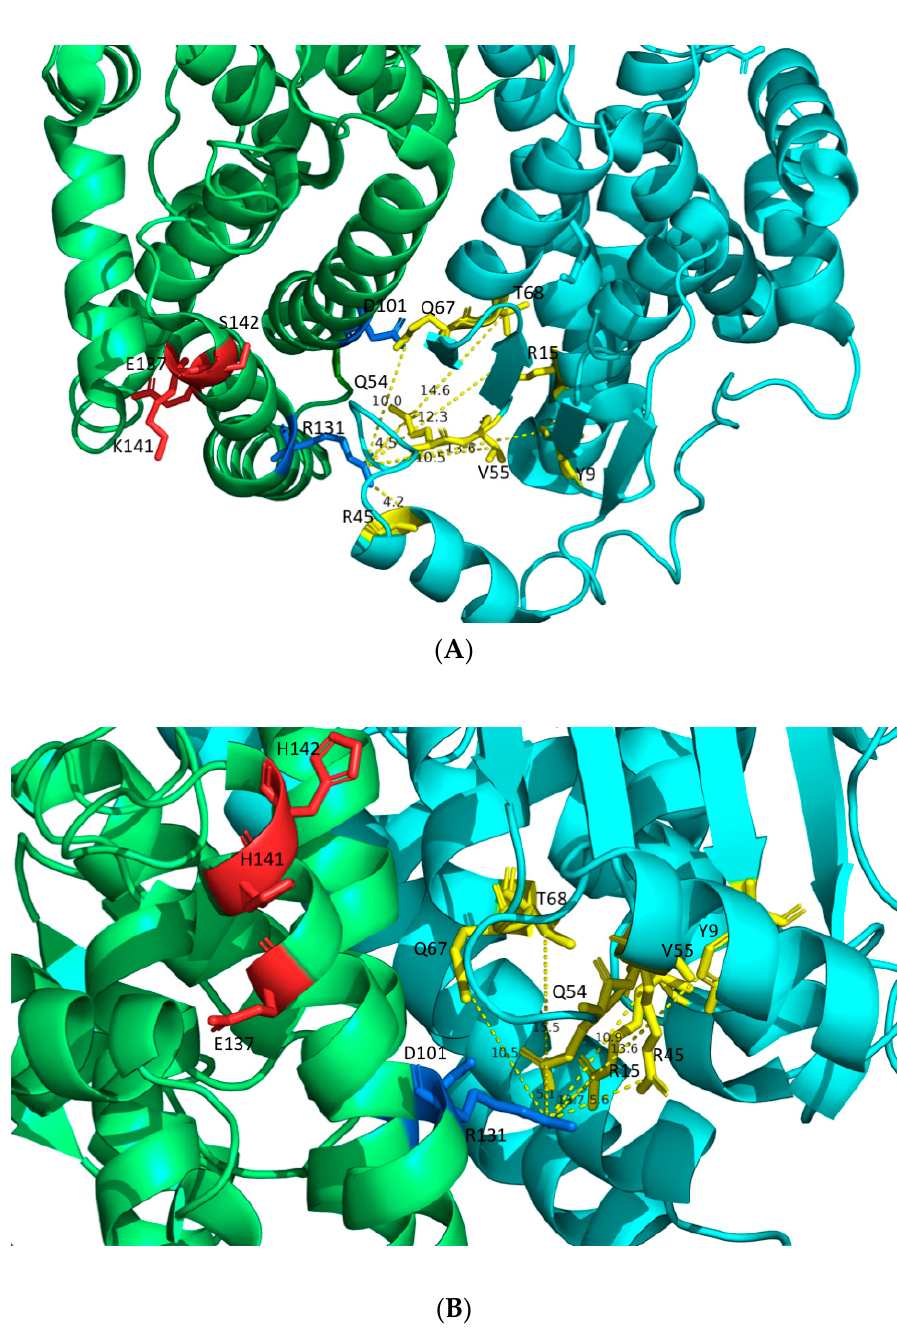
Figure 9. ( A ) Distances between R131 ′ and G-site residues of hGSTA1 (PDB code: 1PKZ [28]). ( B ) Distances between R131 ′ and G-site residues of hGSTA1-K141H/S142H. The distances are shown in dashed yellow lines. The G-site residues of the enzymes (Y9, R15, R45, Q54, V55, Q67, and T68) are presented in yellow. The two molecules of the dimer are shown in lime green and cyan. The residues D101 and R131 of the second molecule in the dimer are presented in marine. The residues E137, K141, S142, H141, and H142 are presented in red. The analysis was carried out using the PyMOL Molecular Graphics System [30].